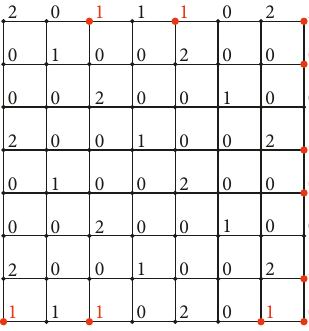
Figure 10: The function f ′ where r � 3 k + 2 , s � 3 l + 2 and r ≡ 2